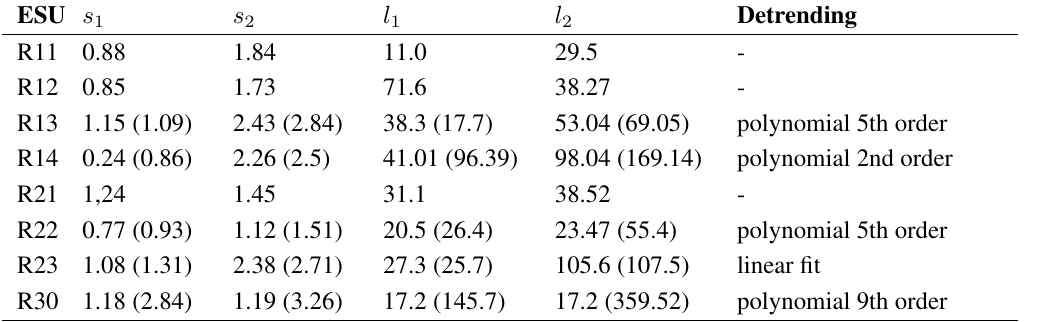
Table 7. Results of two scale roughness representation and order of fitted detrending surface. In brackets are the results for the non-detrended original